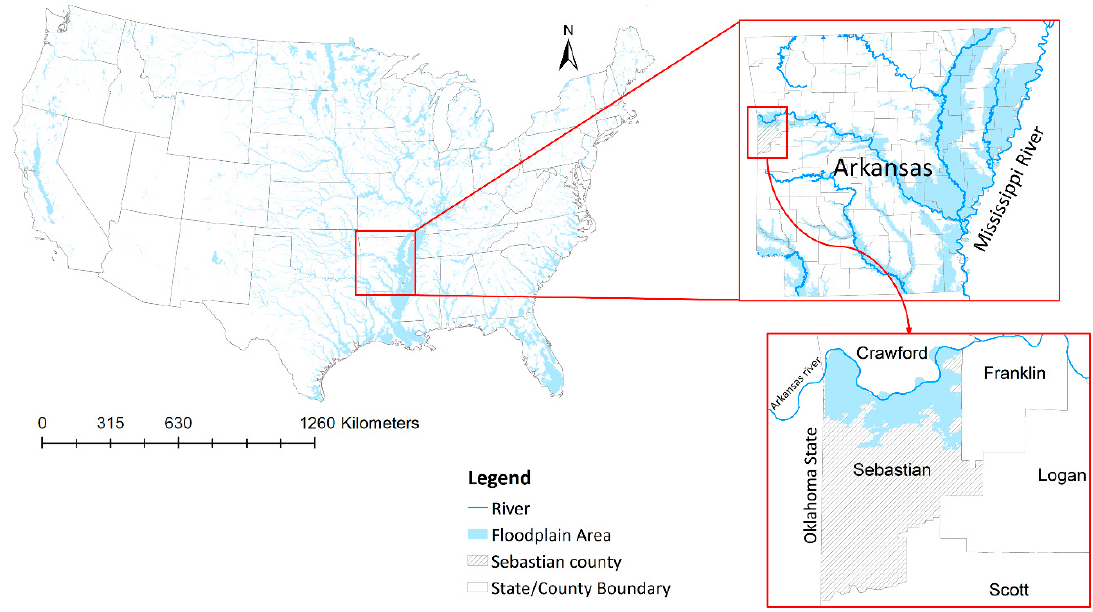
Figure 1. The contiguous US with states boundaries, floodplains area, and a focus on the state of Arkansas and Sebastian county with boundaries and floodplains area. Table 1. Datasets used for spatial and temporal analysis of floodplain population dynamics, historical flood events, and intervention measures.